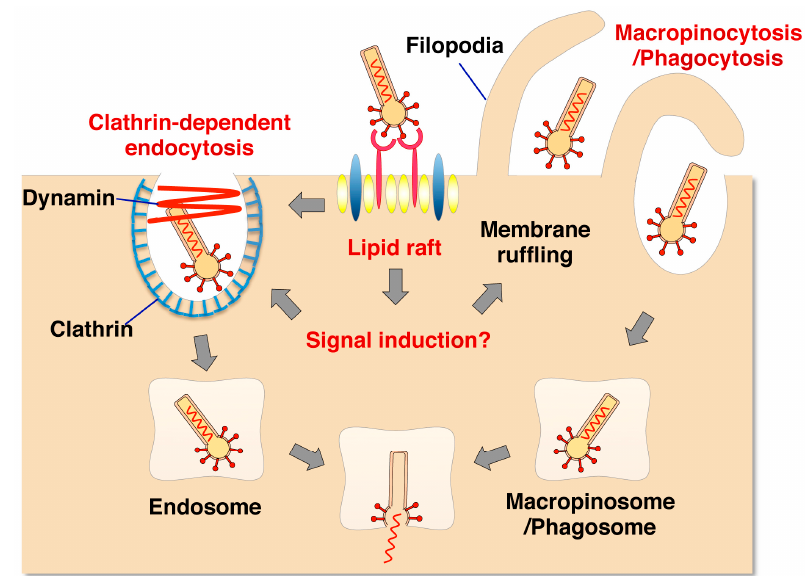
Figure 1. Putative model of internalization of baculovirus into mammalian cells. Baculovirus binds to HSPG or cellular receptor(s) present in the lipid raft. This association induces cellular remodeling through signal transduction. In clathrin-mediated endocytosis, baculovirus is internalized into the clathrin-coated pit. In macropinocytosis [37] or phagocytosis [40], filopodia formed by actin dynamics wrap the baculovirus into a macropinosome or phagosome. The viral genome is released from the endosome, macropinosome or phagosome through membrane fusion induced by low pH (Kataoka et al. [37], with modification).